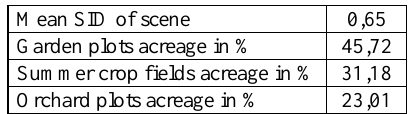
Table 9. Mean SID and cropping system acreage in %, calculated for the region of